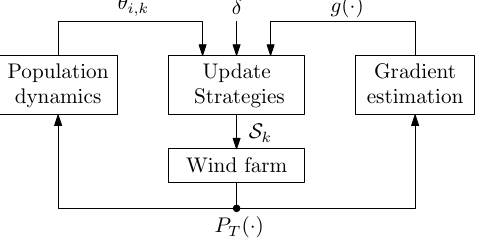
Figure 4. General scheme for the gradient-estimation-based algorithm with population-games